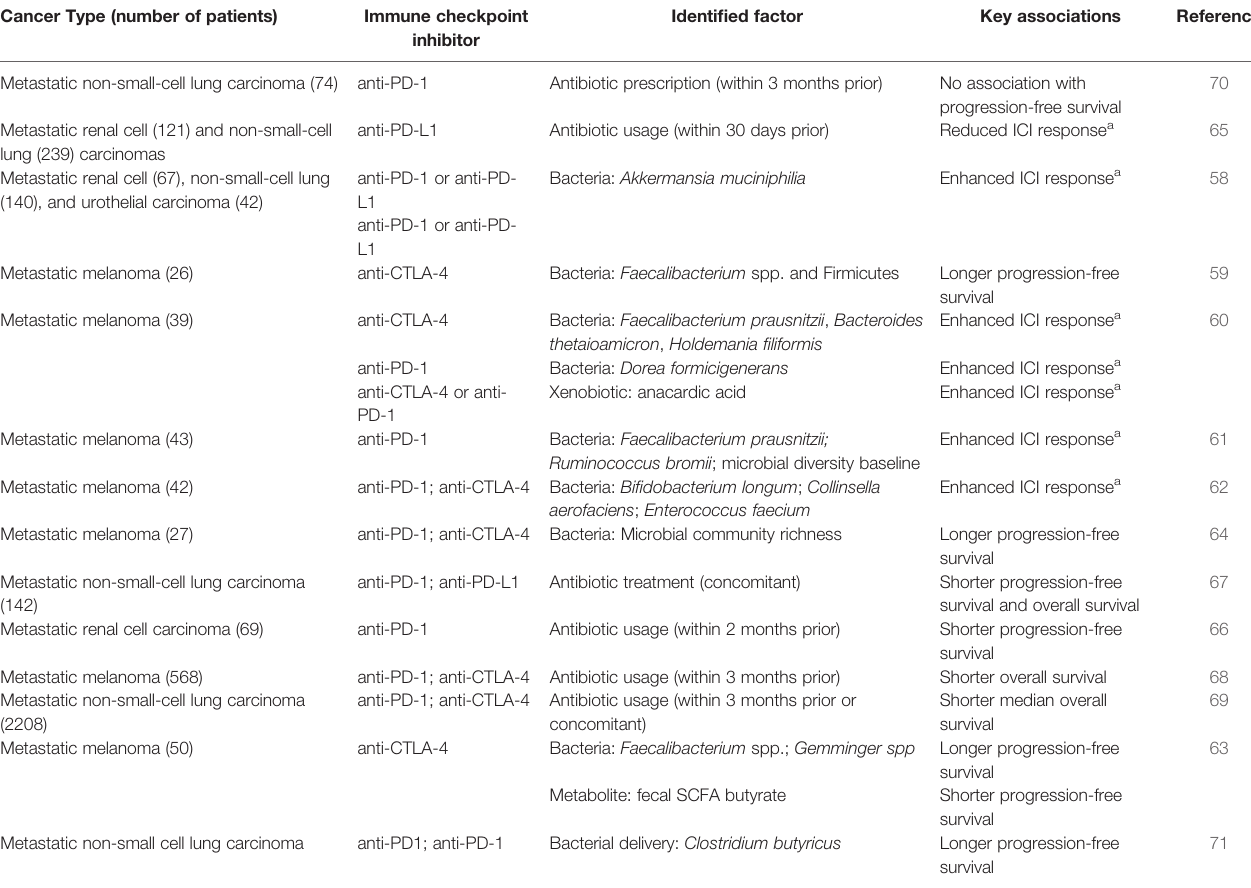
TABLE 1 | Gut microbial composition is associated with the ef fi cacy of immune checkpoint inhibitor therapy in patients. Cancer Type (number of